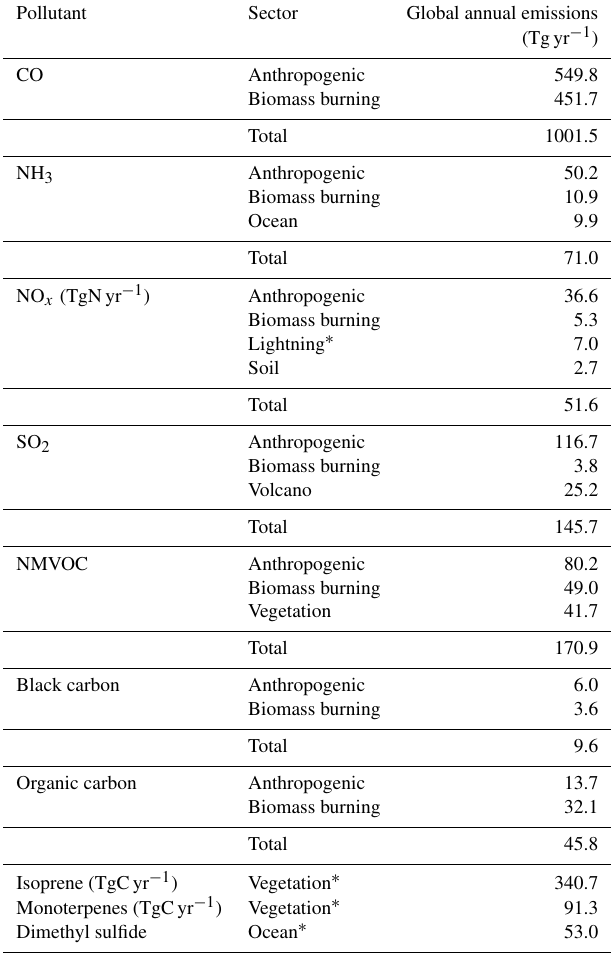
Table 1. Global annual emissions of reactive non-methane gases and